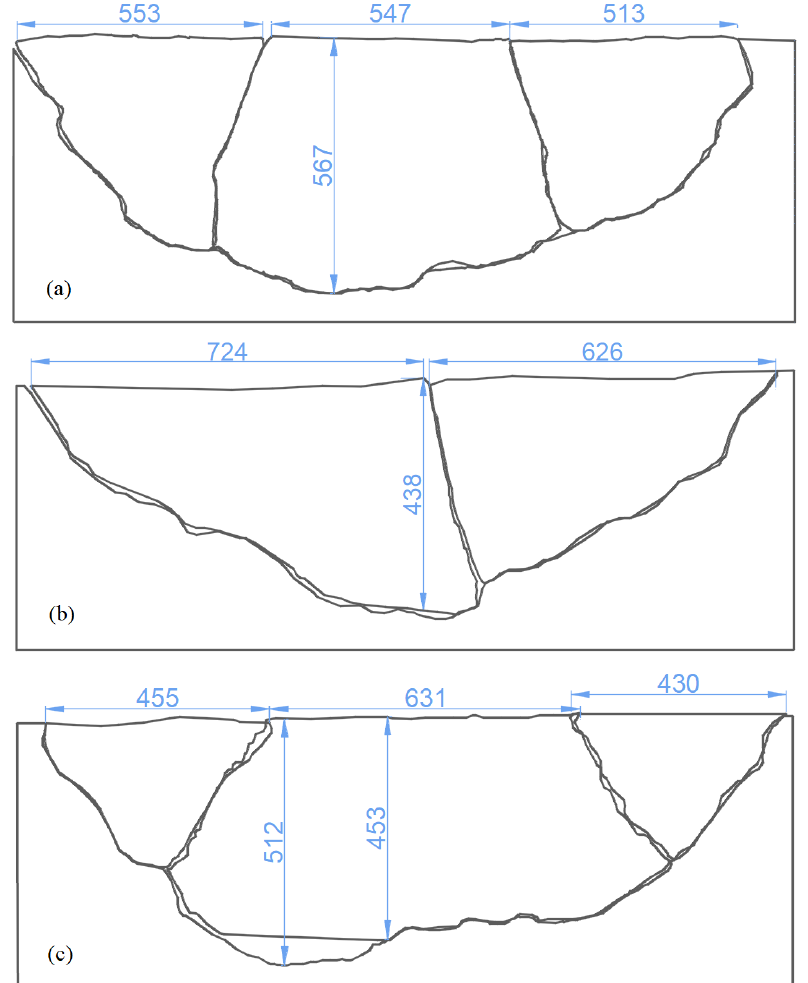
Figure 8. Reconstruction of broken ice mosaic after the first episode of a sloping structure – ice sheet contact obtained in experiments: ( a ) Plane 1; ( b ) Plane 2; ( c ) Plane 3.